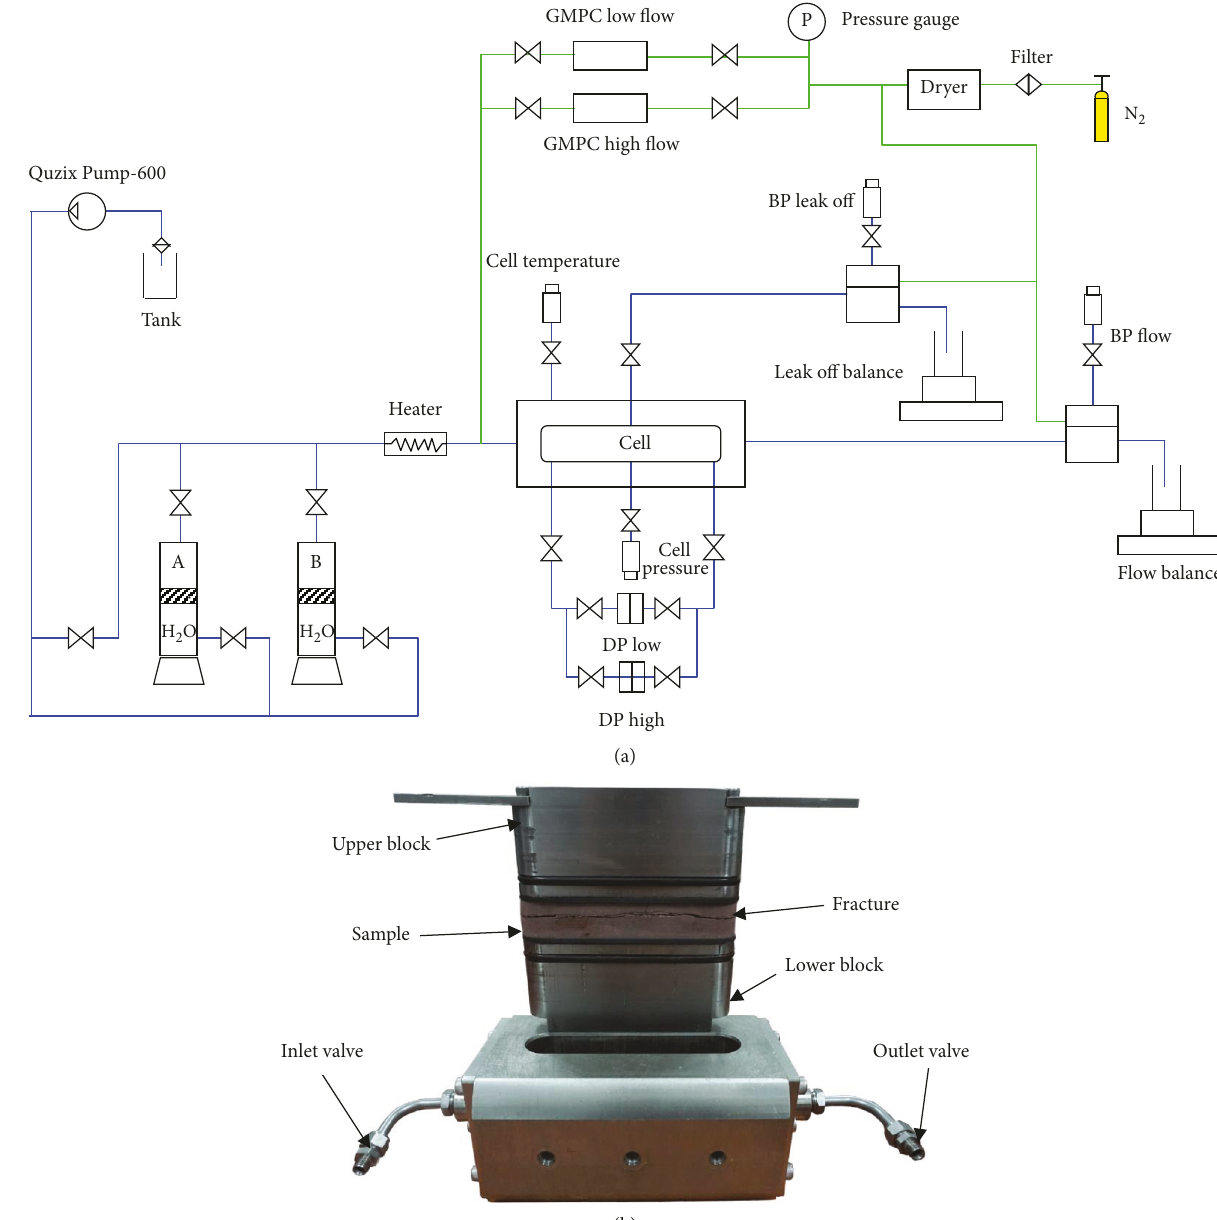
Figure 6: Experimental apparatus pictures. Retention (blue) and gas-displacing (green) systems: (a) sketch map and (b) physical